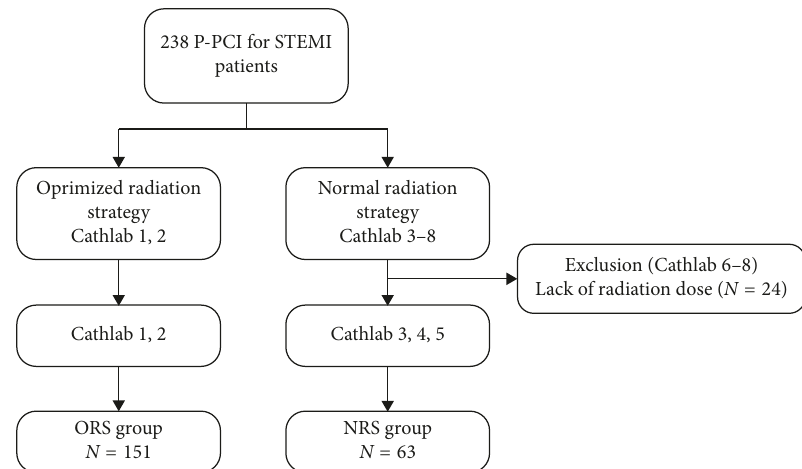
Figure 1: Flow chart of the study. P-PCI, primary percutaneous coronary intervention; STEMI, ST-segment–elevation myocardial in- farction; ORS, optimized radiation strategy; NRS, normal radiation